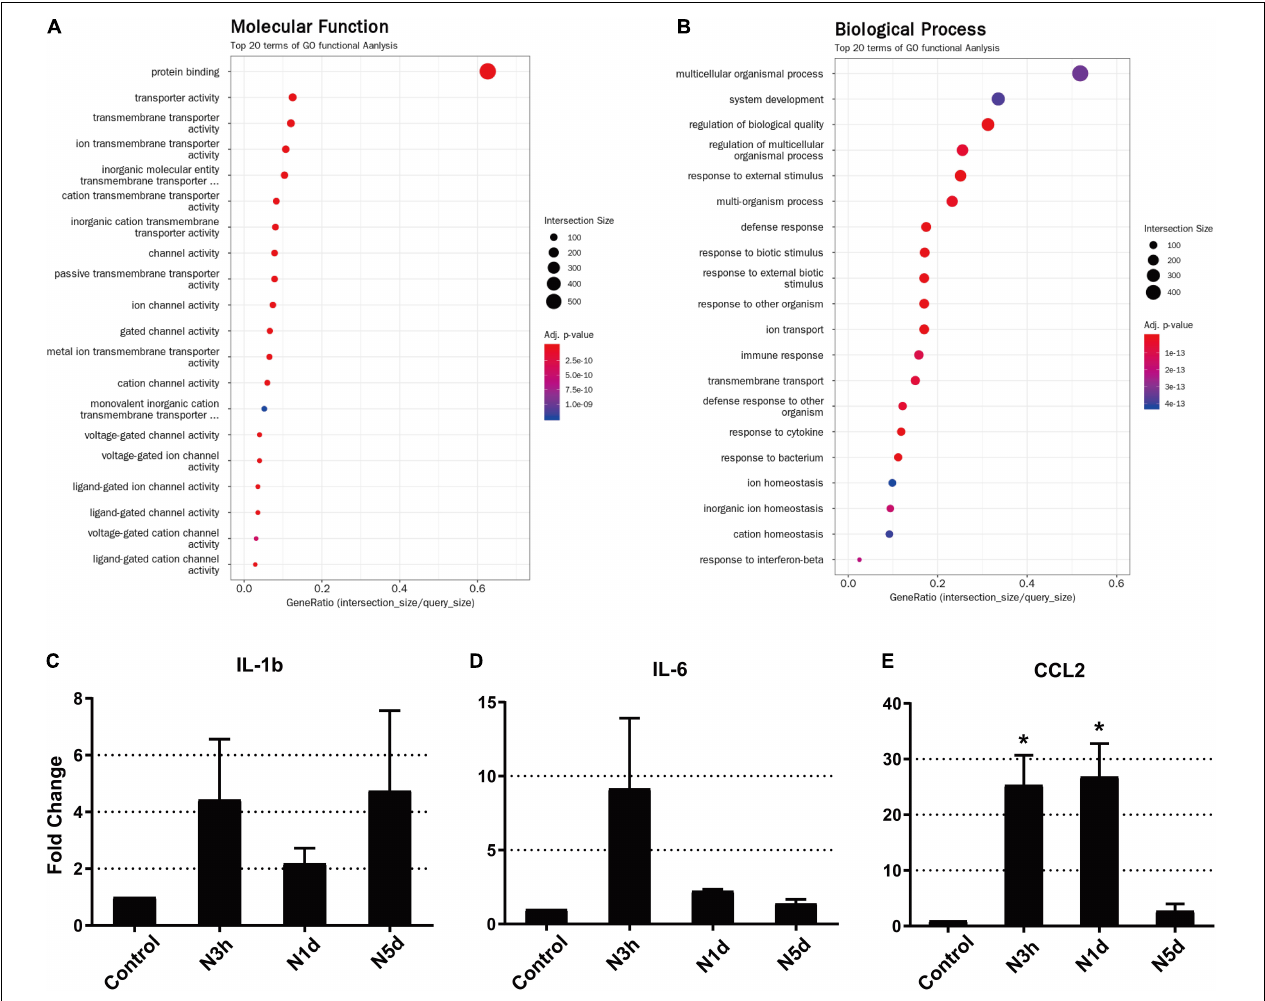
FIGURE 5 | Ccl2 was significantly upregulated as early as 3 h after acoustic overstimulation. (A) Gene Ontology analysis of molecular functions using RNA-sequencing data. (B) Gene Ontology analysis of biological processes. The top 20 terms are shown. (C–E) Expression of inflammatory molecules was analyzed by quantitative polymerase chain reaction ( N = 4 biological replicates in each sample). IL-1b : interleukin 1 beta, IL-6 : interleukin 6, CCL2 : C-C motif chemokine ligand 2, N3h : 3 h after noise, N1d : 1 day after noise, N5d : 5 days after noise. *: p <